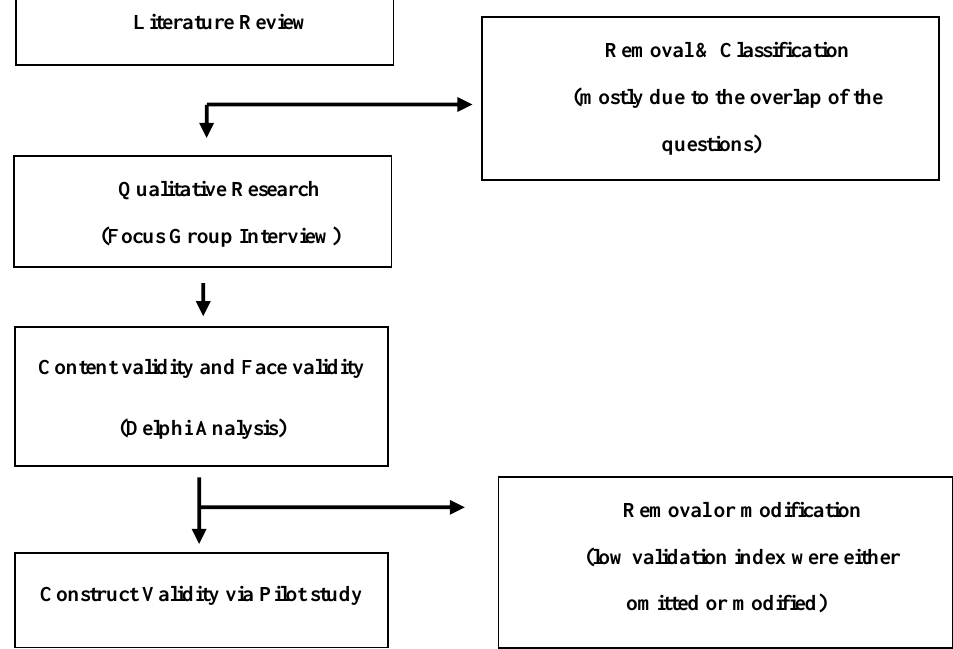
Figure 1. Flow chart of the development and validation of the food literacy questionnaire